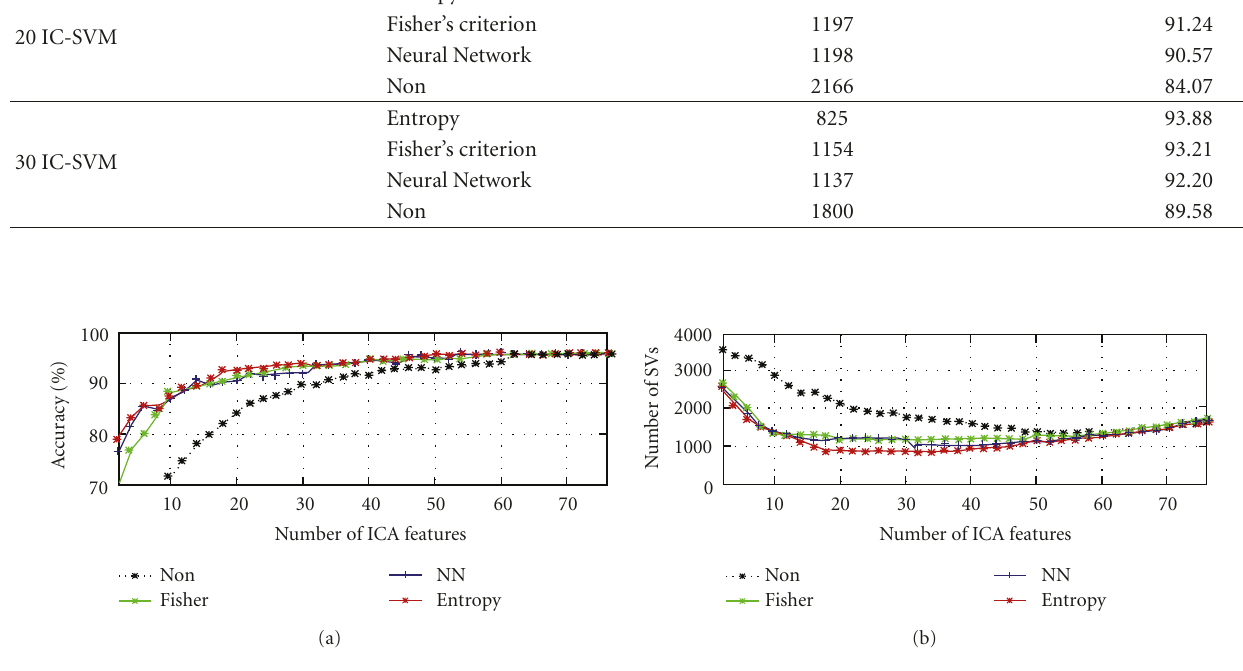
Figure 11: Analysis of feature selection. (a) Accuracy rate. (b) Number of